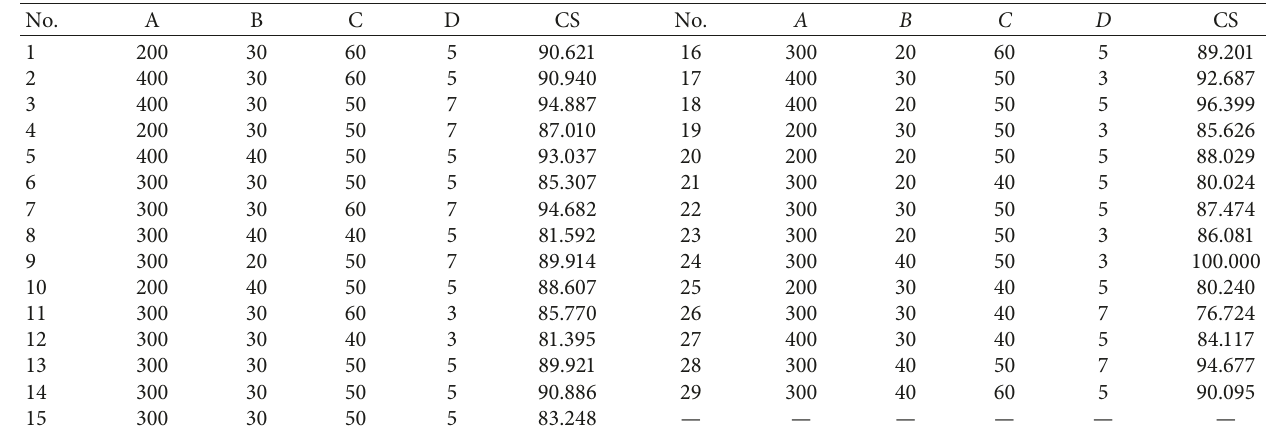
Table 4: Response surface test design and results.